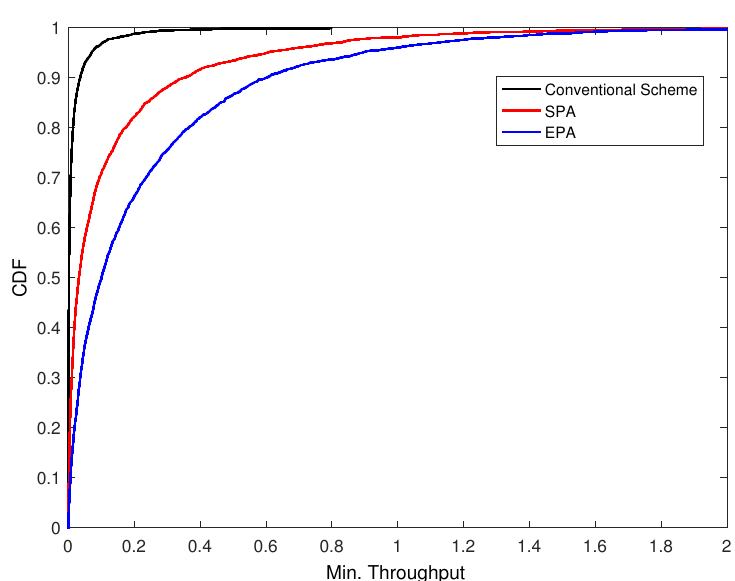
Figure 10. The CDF of min. uplink rate when M = 64 using ZF.